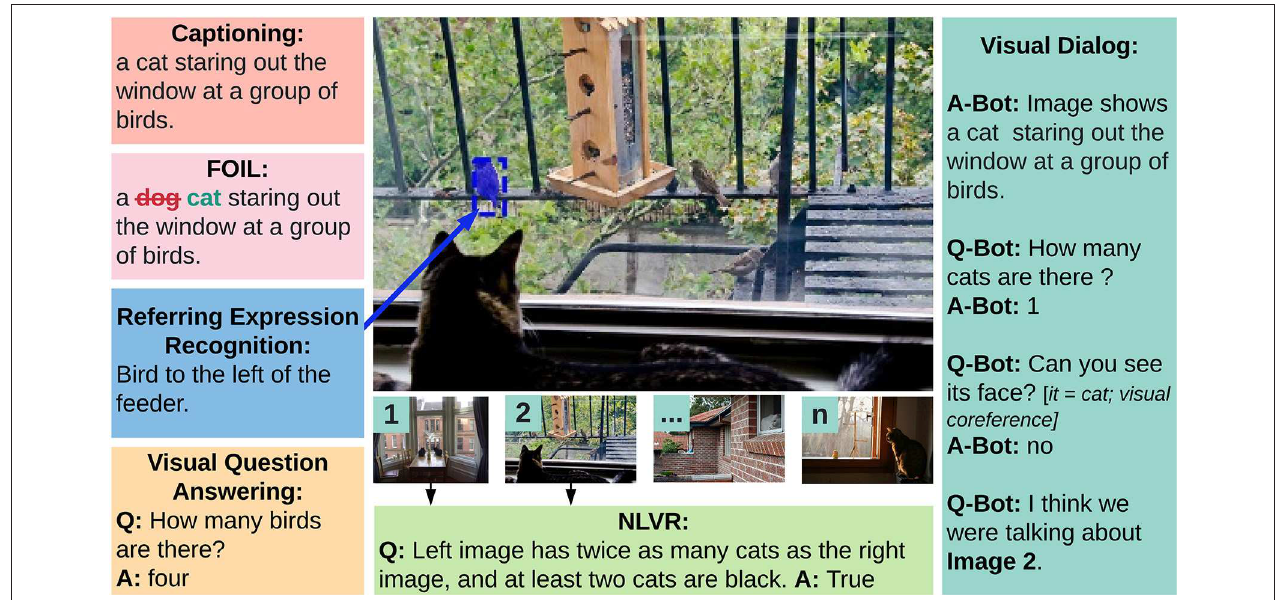
FIGURE 1 | Common tasks in vision and language